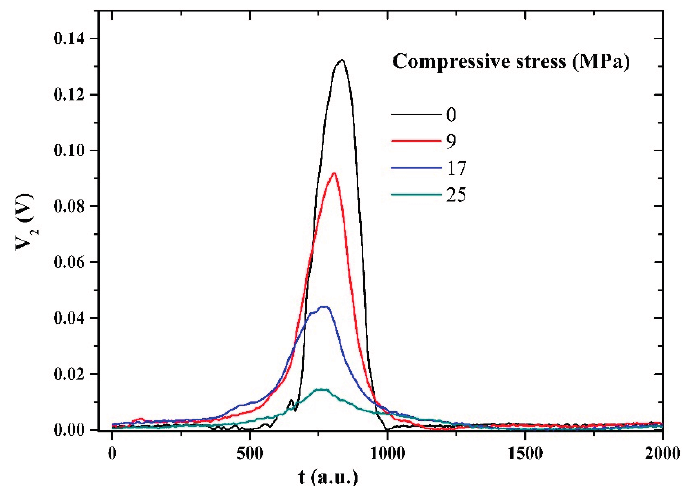
Figure 8. Change of shape (peak amplitude and peak position) of the voltage from the pick-up coil (V 2 ) under applied compressive stress.